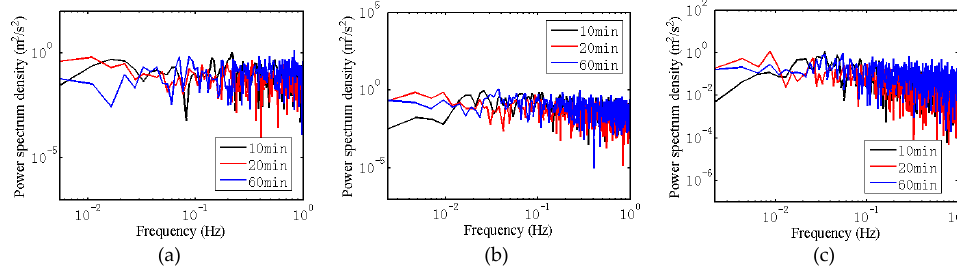
Figure 30. Power spectra of the longitudinal wind component for different time interval at ( a ) 10 m, ( b ) 80 m, and ( c ) 100 m.